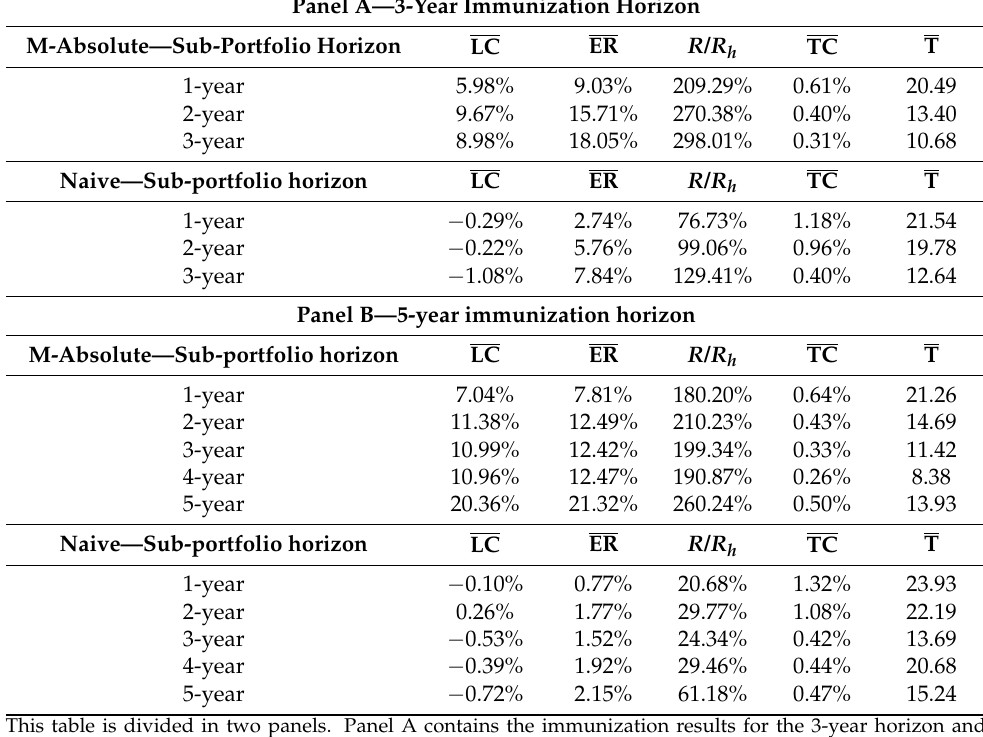
Table 2. U.S. TIPS with Inflation Accrual Immunization